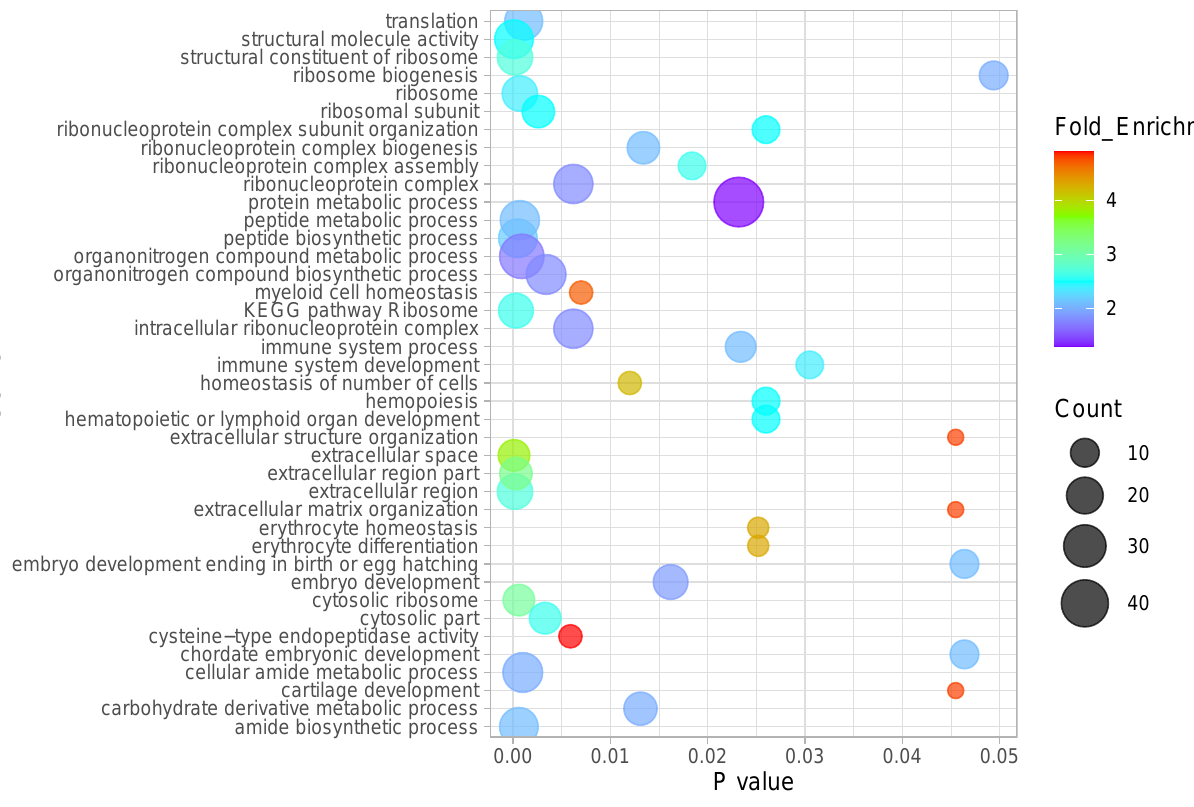
Figure 6. Overrepresented biological process GO terms ( p < 0.05) in the set of genes which were significant for the Race factor in the two-way